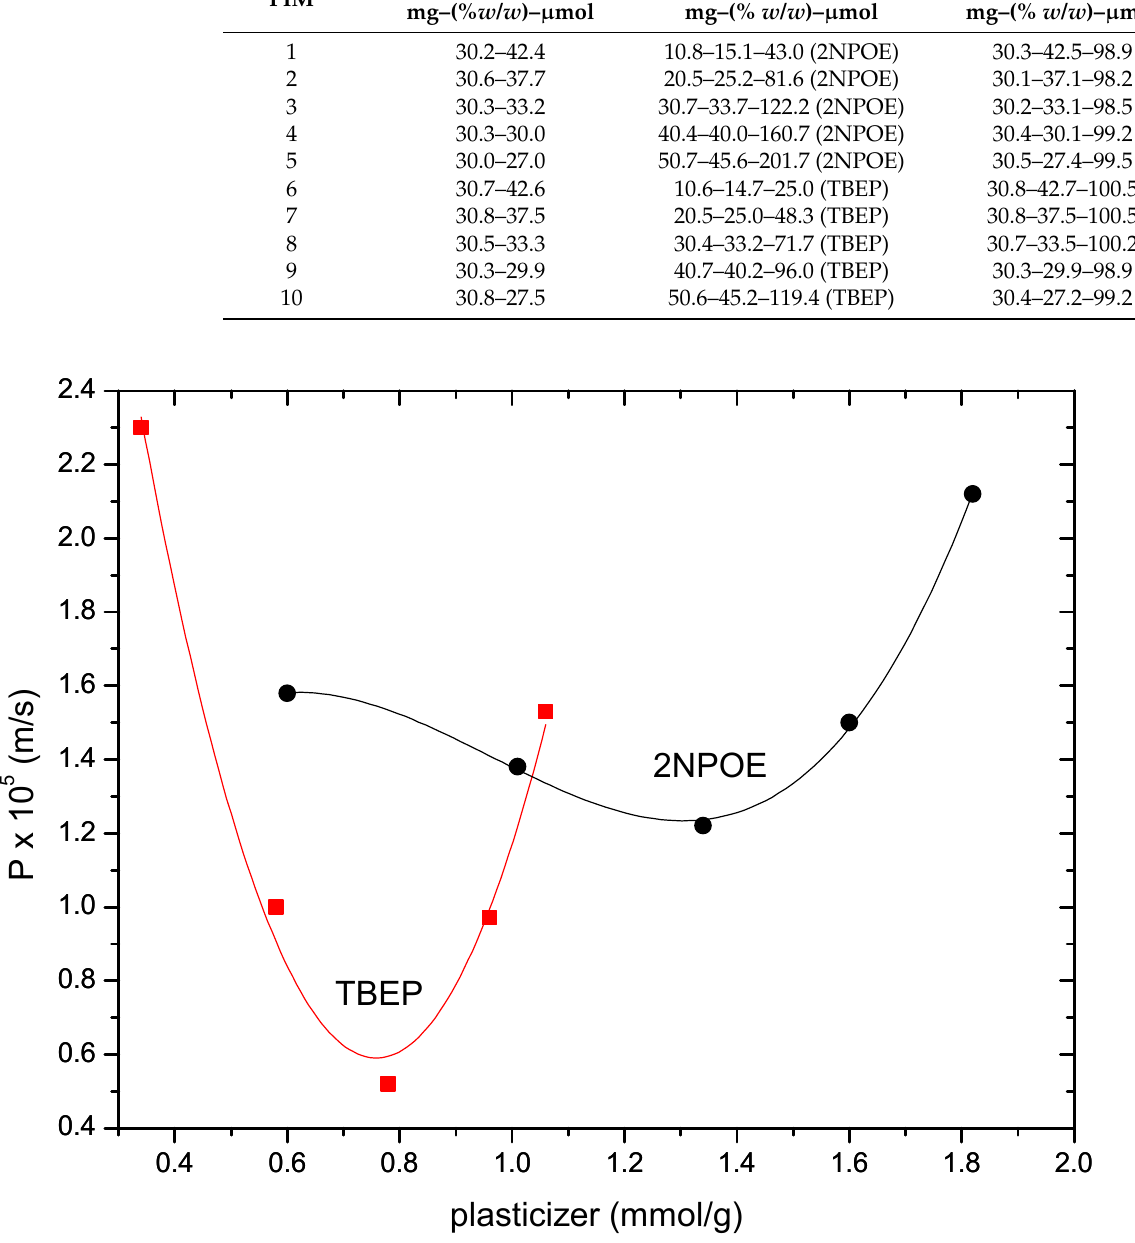
Figure 3. Indium (III) permeability profiles for PIMs 1–5 (2NPOE) and 6–10 (TBEP) at variable plasticizers’ concentration.